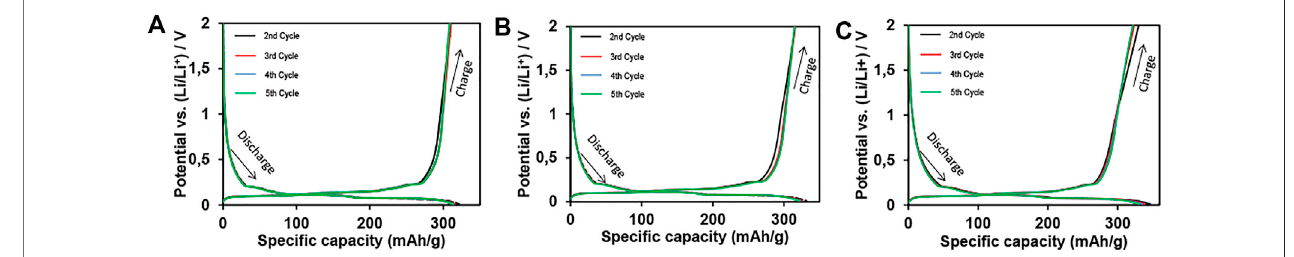
FIGURE5| Charge – dischargepro fi lesforthesecondto fi fthgalvanostaticcyclesof (A) NP1, (B) NP2,and (C) NP3electrodesatacurrentrateofC/20.Note:10 wt % of GNPs is used in graphene-based electrodes; the total active material is 94.5 wt%.